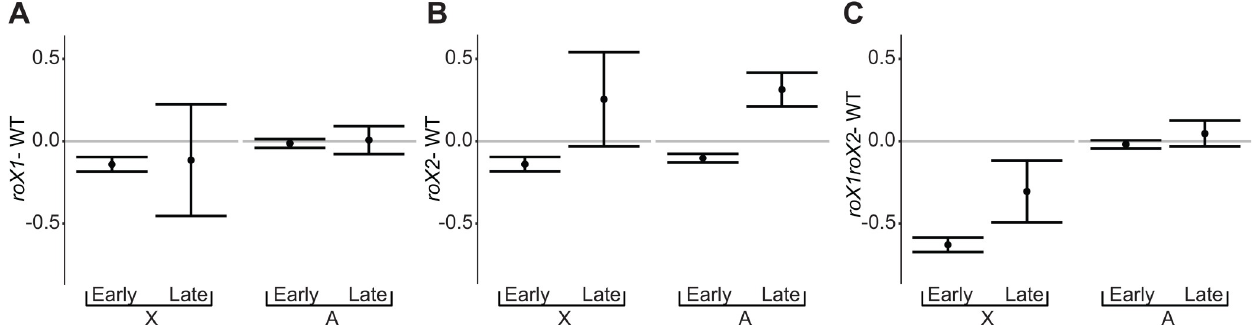
Fig 6. Differential effects of roX mutations on early and late replicating genes. Average expression ratios of X chromosomal (X) and autosomal (A) genes in; (A) roX1 –WT, (B) roX2 –WT, (C) roX1 roX2 —WT. The genes are grouped by their replication time in S2 cultured cells and the expression ratios are calculated from the RNA-seq analysis on first instar larvae. The error bars represent 95% confidence intervals.